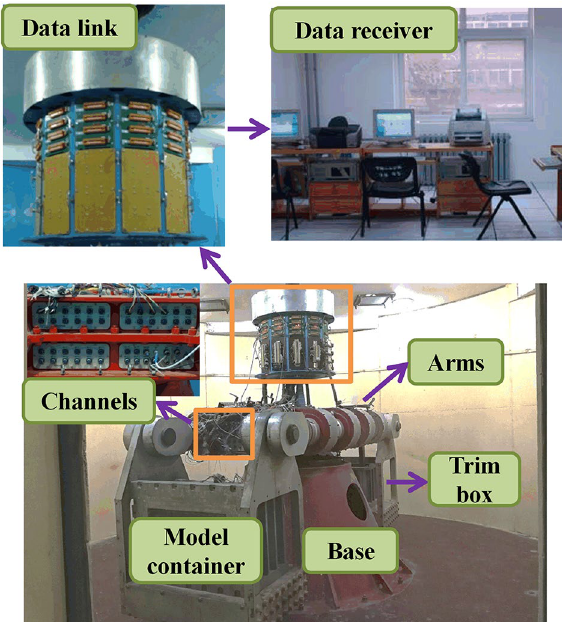
Figure 11. TLJ-3 type centrifuge.